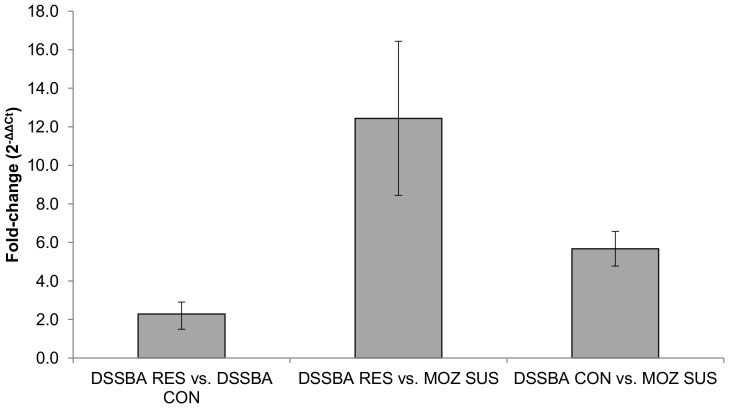
Fold-change in GSTD3 expression for microarray comparisons using quantitative qPCR.Fold changes are expressed using the 2−ΔΔCt formula with 95% C.I. [39].